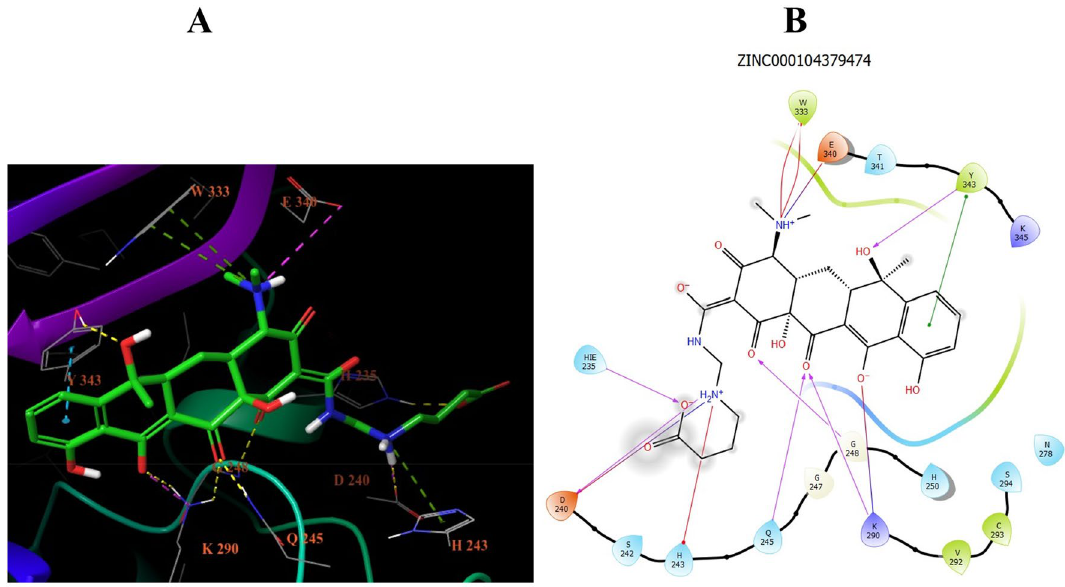
Figure 3. The 2D and 3D interactions between the IF docking of ZINC000104379474 and NSP15. There are 12 interactions in total. Half of them (six interactions) are H-bonds between H235, D240, Q245, G248, K290, and Y343, followed by three salt bridges (D240, K290, and E340), then one Pi-cation (H243) interaction and two Pi–Pi stacking